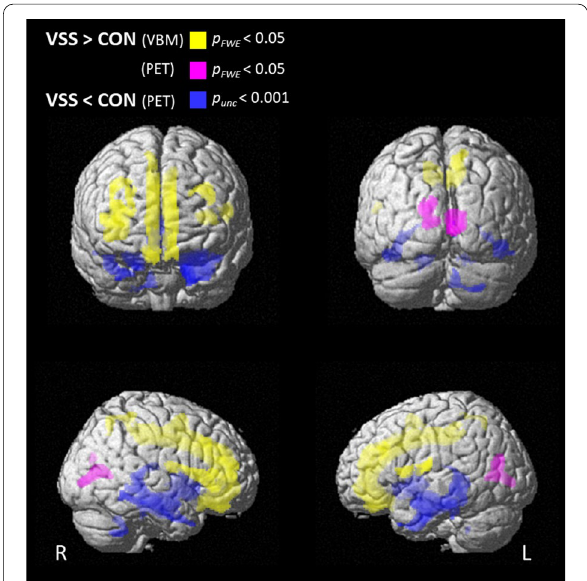
Fig. 3 Differences in brain grey matter volume GMV (voxel-based morphometry, VBM) and glucose metabolism (PET) between patients with visual snow syndrome (VSS) and controls (CON). Surface rendering showing brain regions with increased grey matter volume (yellow), increased glucose metabolism (purple) ( p FWE < 0.05) and decreased glucose metabolism (blue; p uncorrected < 0.001) in VSS compared to CON